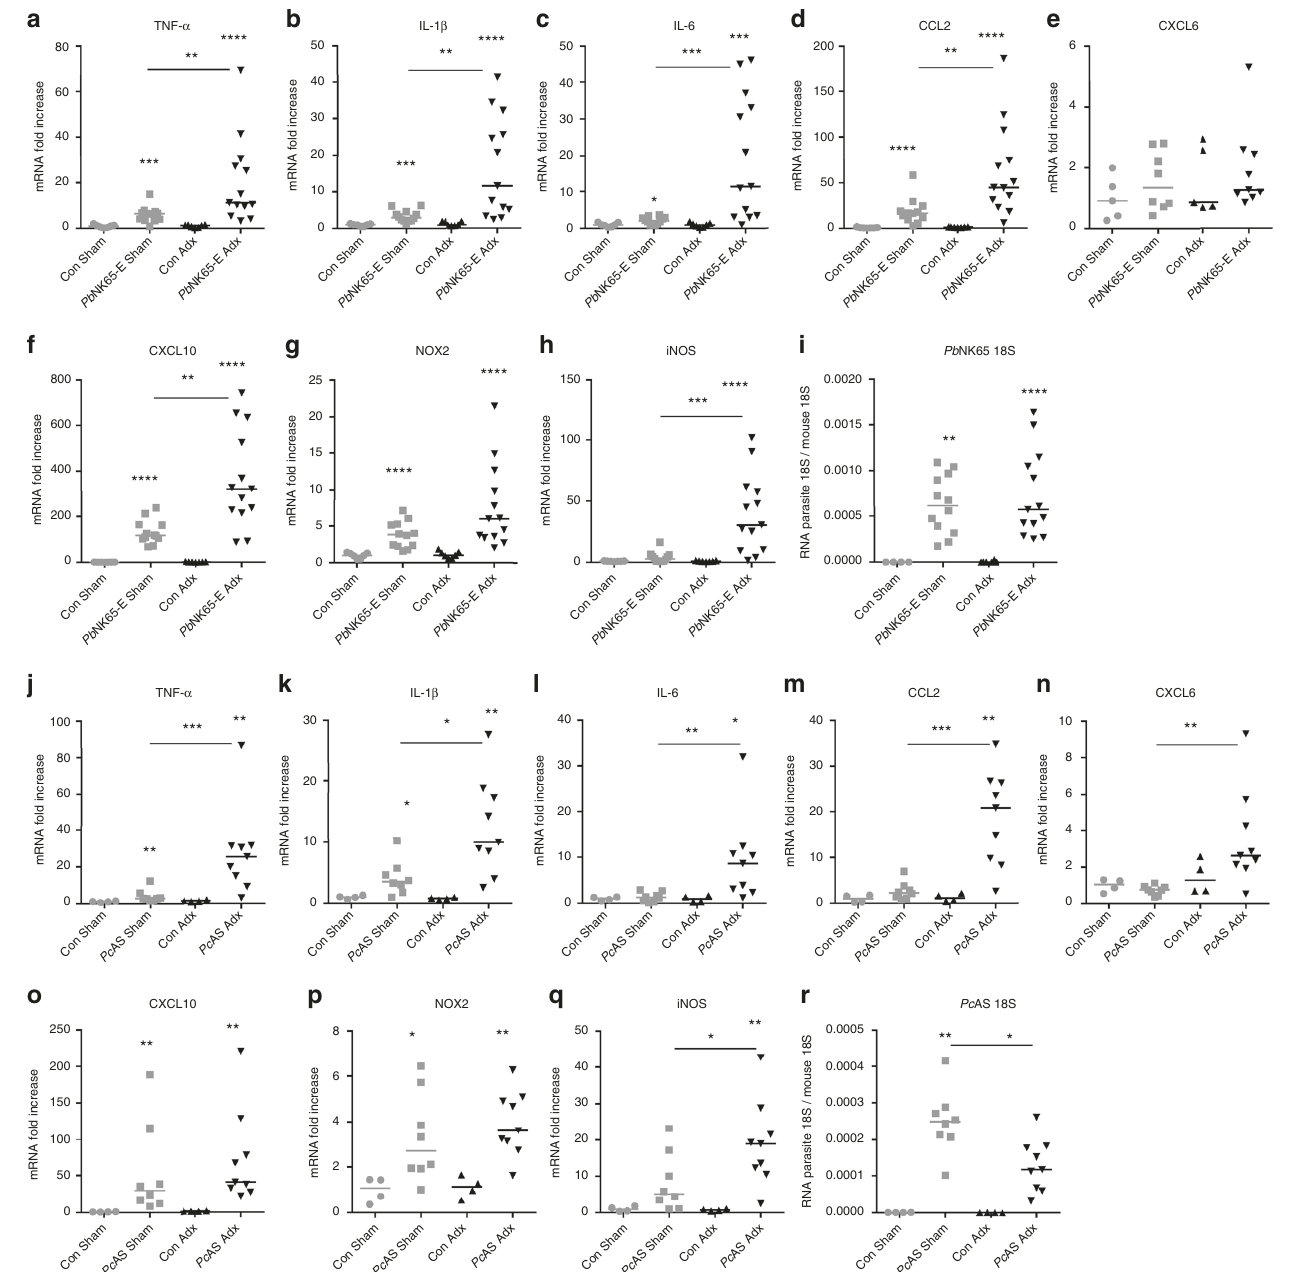
Fig. 3 Pro-in fl ammatory cytokine and chemokine expression is increased in the brain of Adx mice upon infection. Sham and Adx BALB/c mice or C57BL/6 mice were infected with Pb NK65-E ( a – i ) or Pc AS ( j – r ), respectively. Infected mice were euthanized and dissected at 6 to 7 days p.i. ( Pb NK65-E) or 8 to 9 days p.i. ( Pc AS). Brains were homogenized and speci fi c mRNA levels were measured by qRT-PCR. Each symbol represents data from an individual mouse. Horizontal lines in between data points represent group medians and analysis was by Mann-Whitney U -test. Horizontal lines with asterisks on top indicate the levels of statistical signi fi cance between the indicated groups. Asterisks above individual data sets indicate the levels of statistical signi fi cance compared to the uninfected control group. Data from at least two separate experiments. * p < 0.05, ** p < 0.01, *** p < 0.001, **** p <